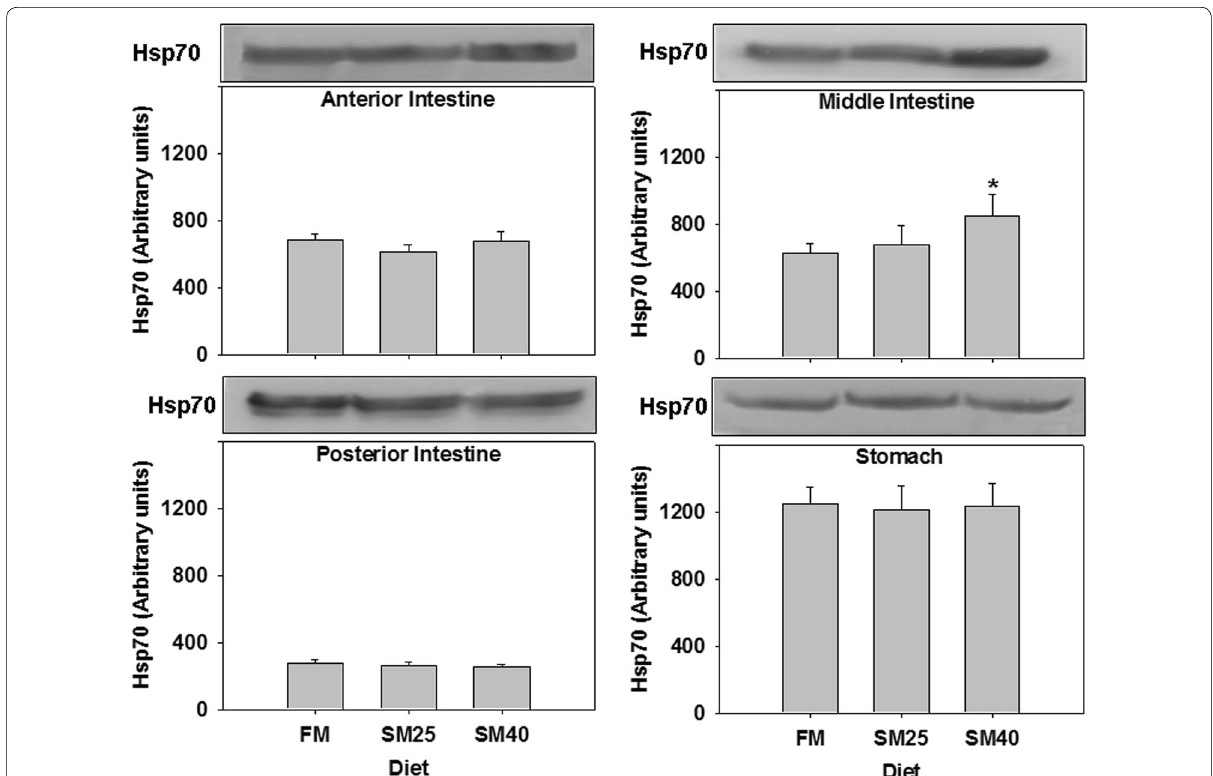
Fig. 1 Induction of Hsp70 in the anterior, middle, posterior intestine and stomach of common dentex ( Dentex dentex ) under the FM, SM25 and SM40 diet treatment. Representative protein bands are shown on the top of the panel. Western blots are representative of at least three independ- ent experiments with overlapping results and data represent mean different animals. * p < 0.05 compared to FM; # p < 0.05 compared to